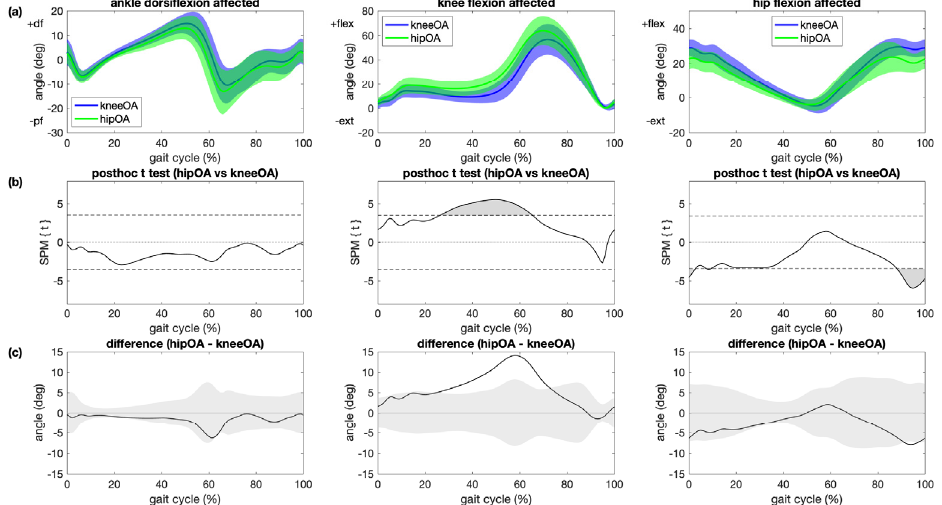
Figure 4. Comparison between patients with knee OA and patients with hip. ( a ) Mean and 1 standard deviation joint angle trajectories for ankle dorsiflexion (left), knee flexion (center) and hip flexion (right) angle for the affected leg for patients with knee OA (blue) and patients with hip OA (green); ( b ) results of statistical parametric mapping with posthoc t tests (SPM{t}) where regions with statisti- cally significant difference between groups are indicated as grey regions ( p < 0.05/3); ( c ) mean joint angle deviation from patients with knee OA for patients with hip OA where grey areas illustrate ± 1 SD of the joint angles of the control